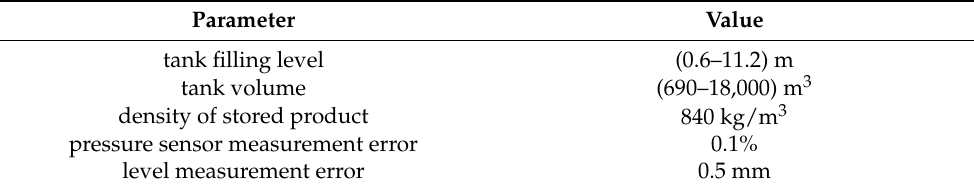
Table 1. The parameters for modeling the mass evaluation